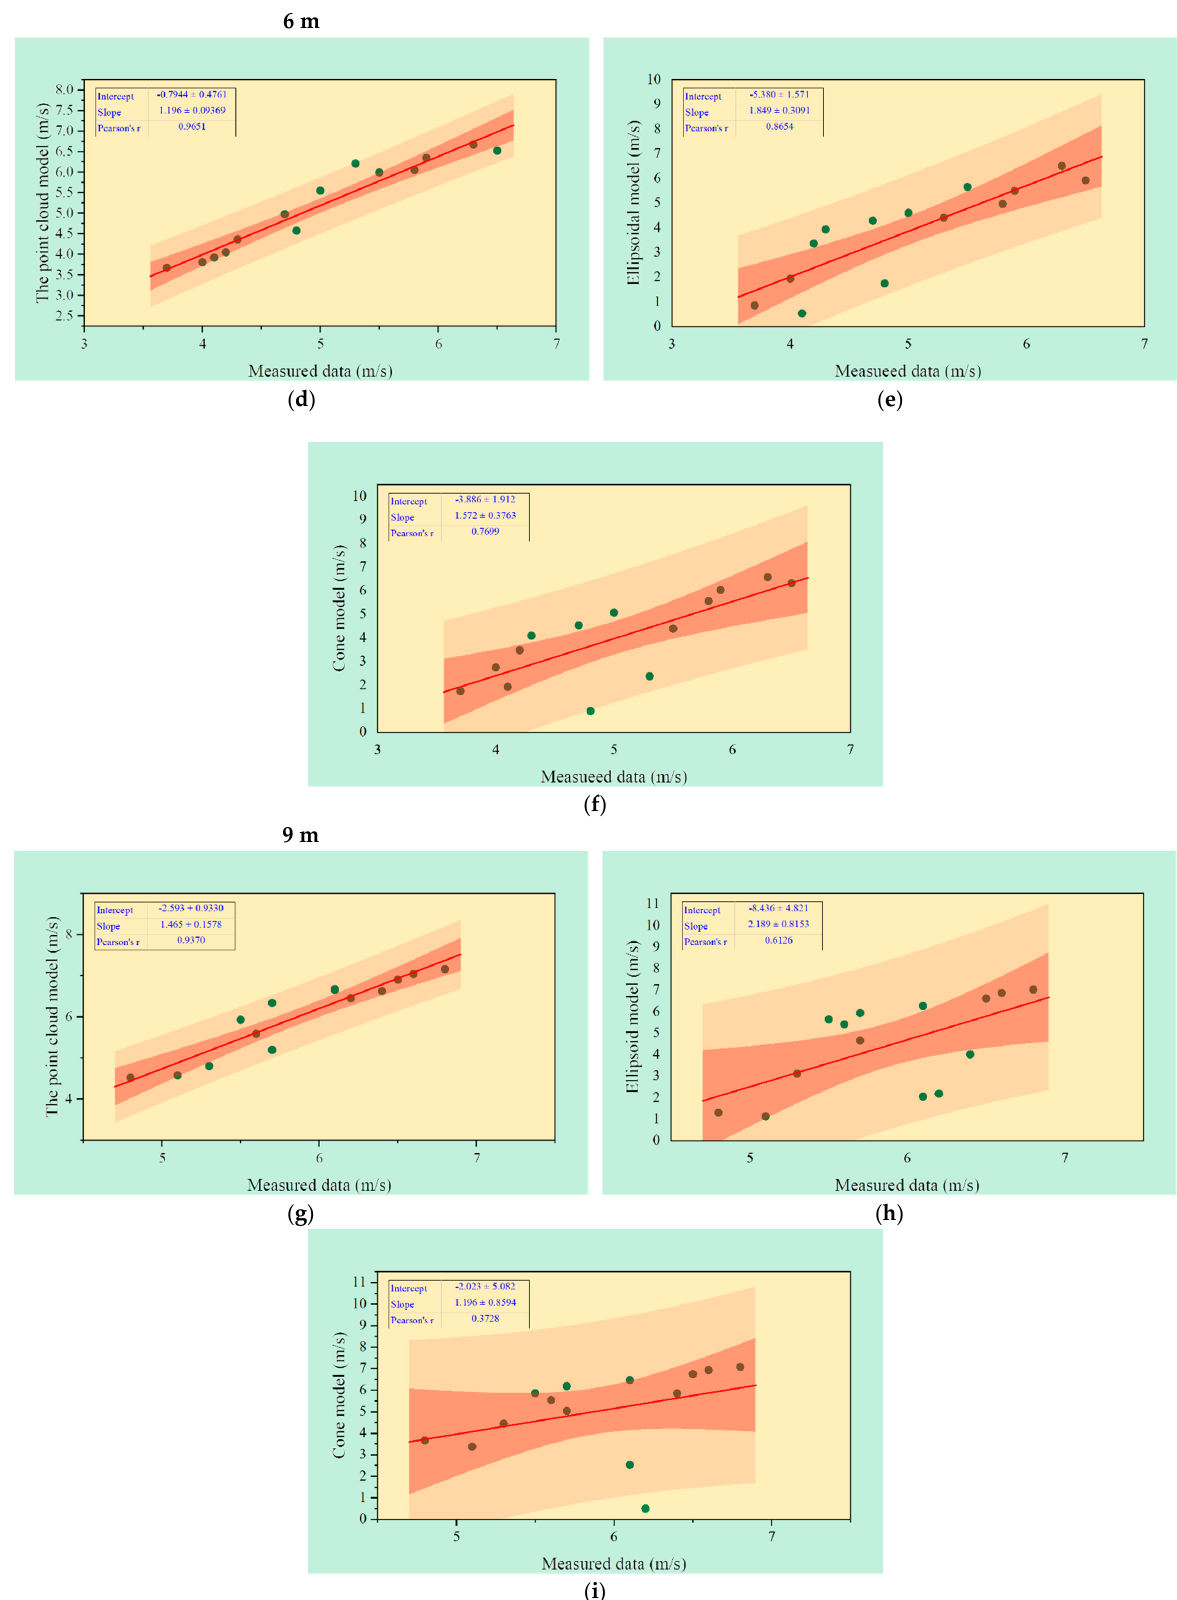
Figure 9. Evaluation of simulated wind speeds for three canopy models at 3-m, 6-m, and 9-m heights. ( a – c ) are fits to data from different model experiments and simulations at 3 m height, ( d – f ) are fits at 6 m, and ( g – i ) are fits at 9 m. The red line indicates the fitted regression, the pink area represents the confidence interval, and the light pink area represents the prediction interval.